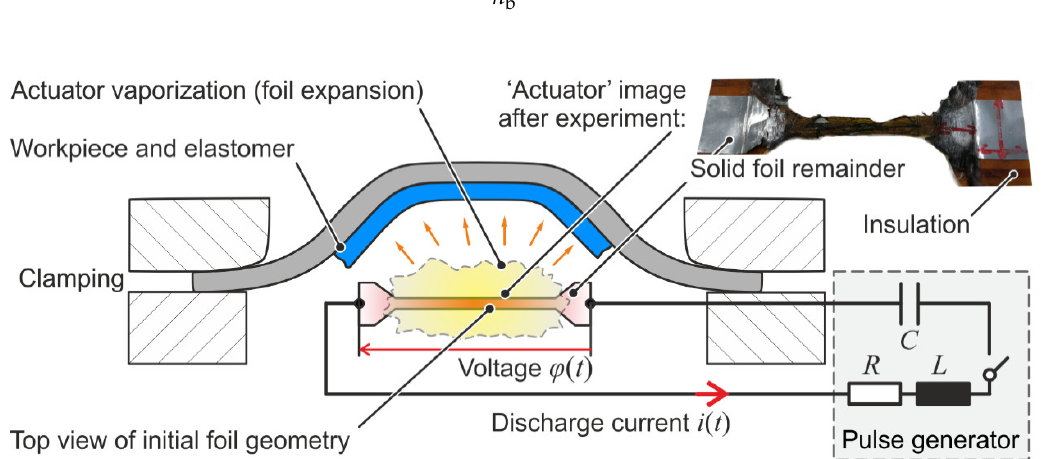
Figure 1. Cross-sectional sketch of VFAF principle.